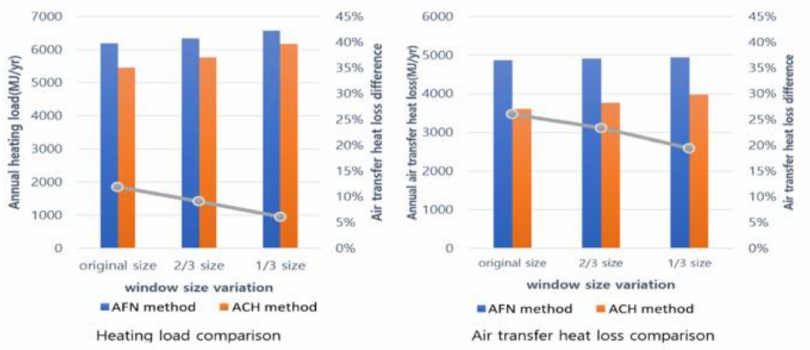
Figure 12. Comparison of the AFN model and ACH model for annual heating load and air transfer heat loss in parametric analysis 2.